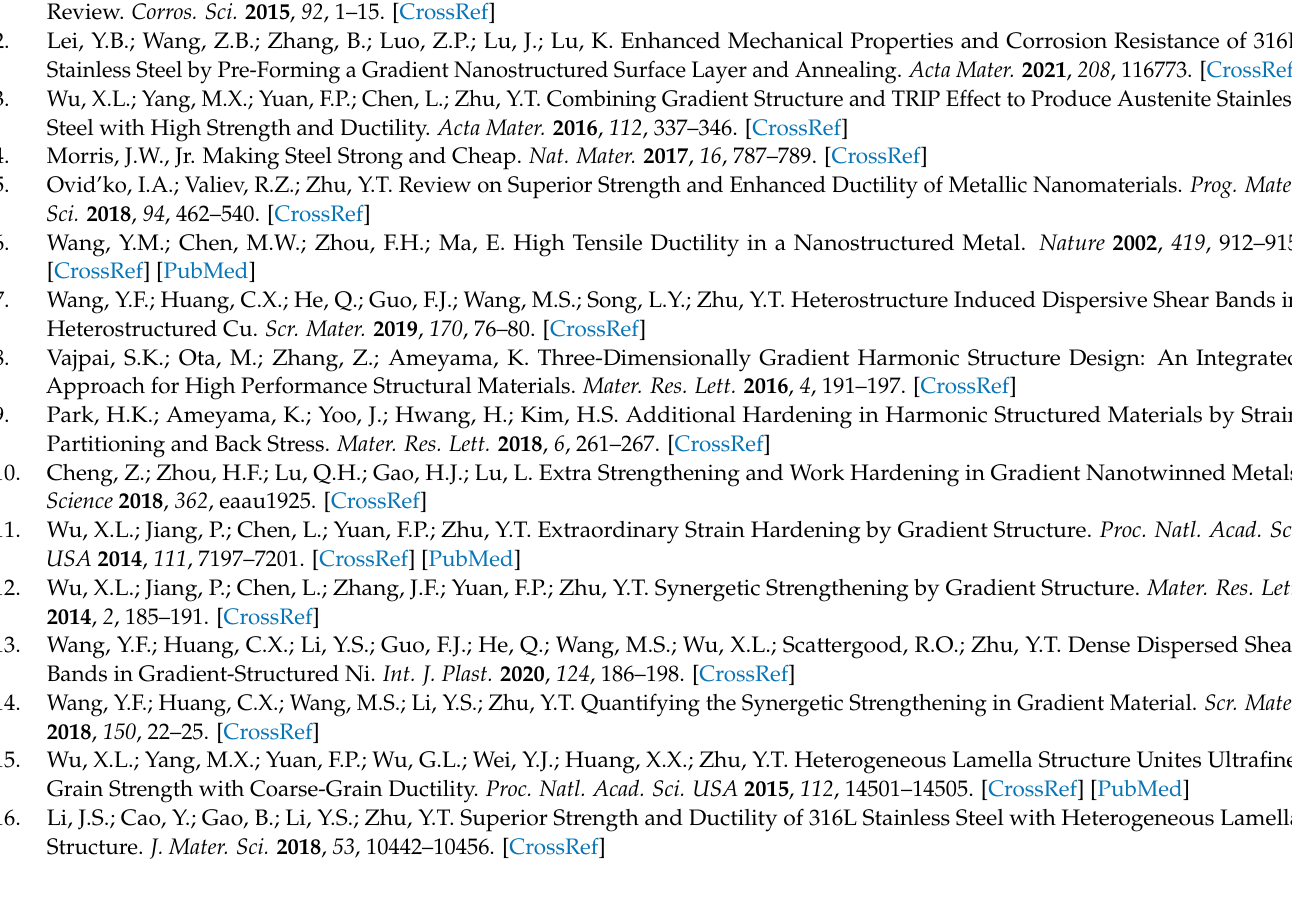
Figure S4: TEM image showing the austenite, twins, ε -martensite and α ’-martensite of as-SMATed